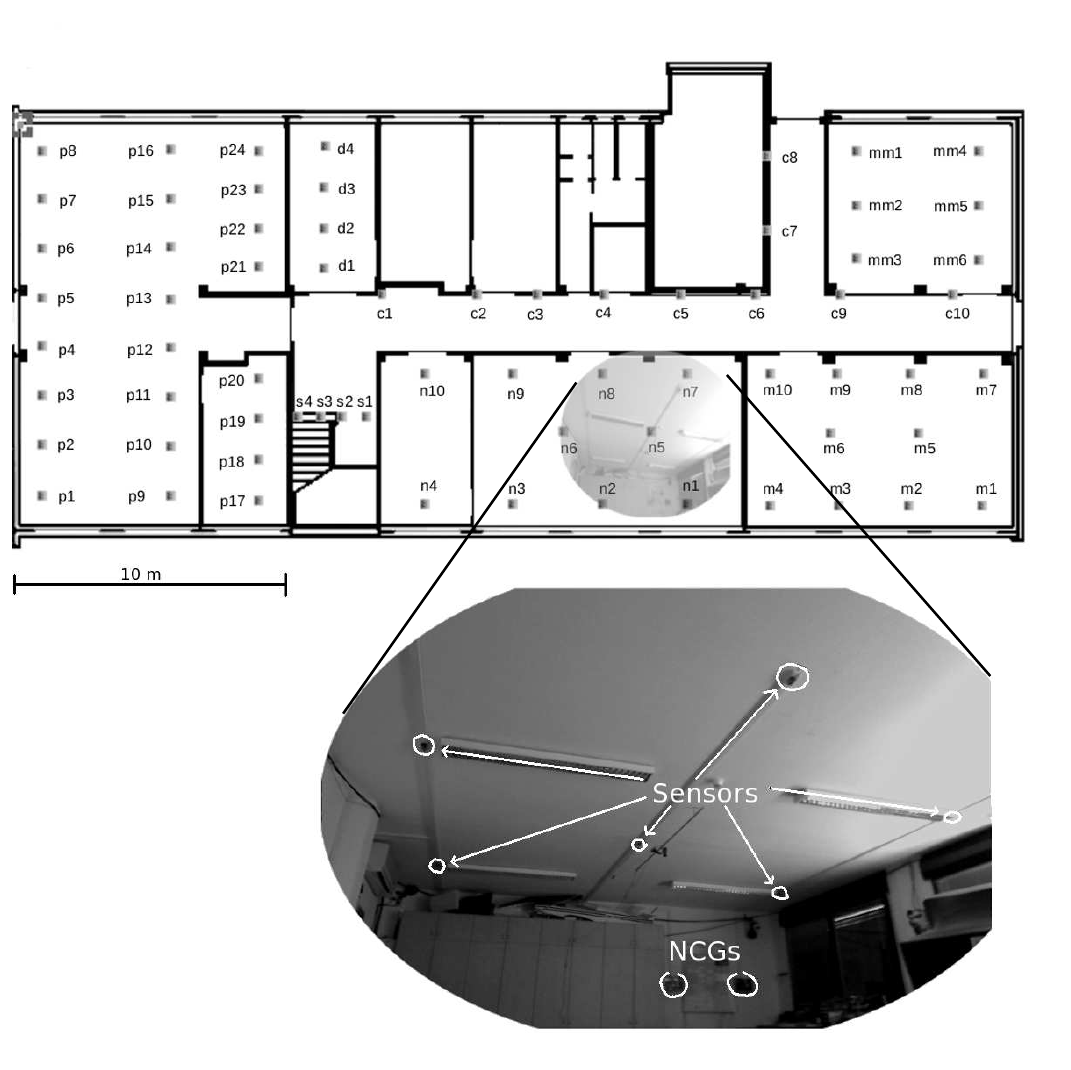
Figure 3. Node displacement map, with a close-up on the arrangement of nodes within one of the